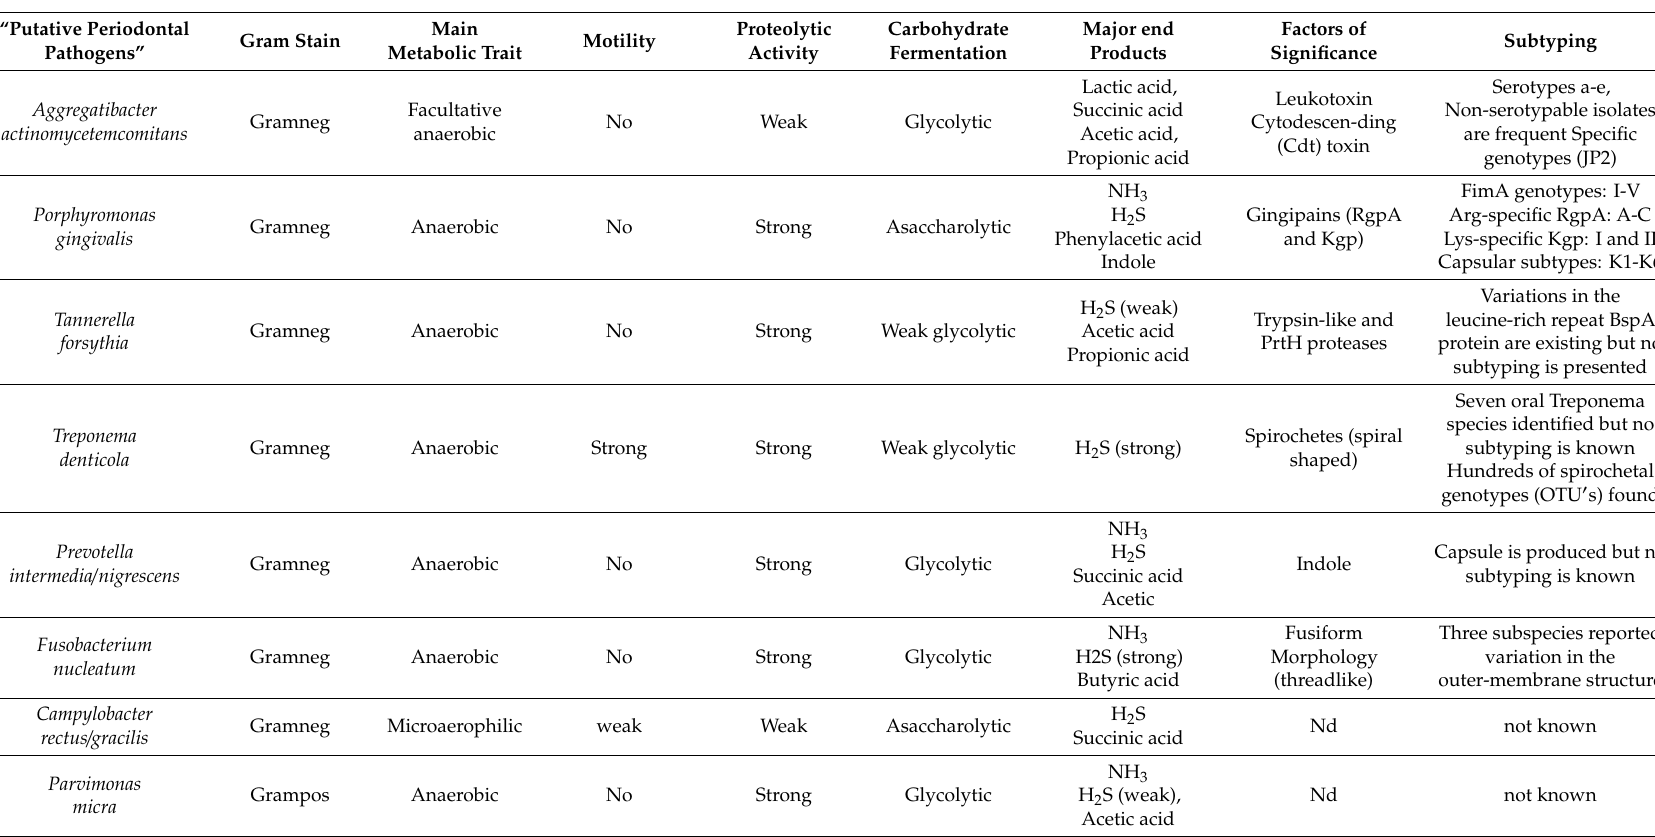
Table 1. Important characteristics for eight “putative periodontal pathogens” as described by Socransky et al. (1998) in colored complexes (as indicated in the table by the red and orange color) associated with periodontitis. A. actinomycetemcomitans (serotype b) did not fit into any of the complexes and is colored grey in the